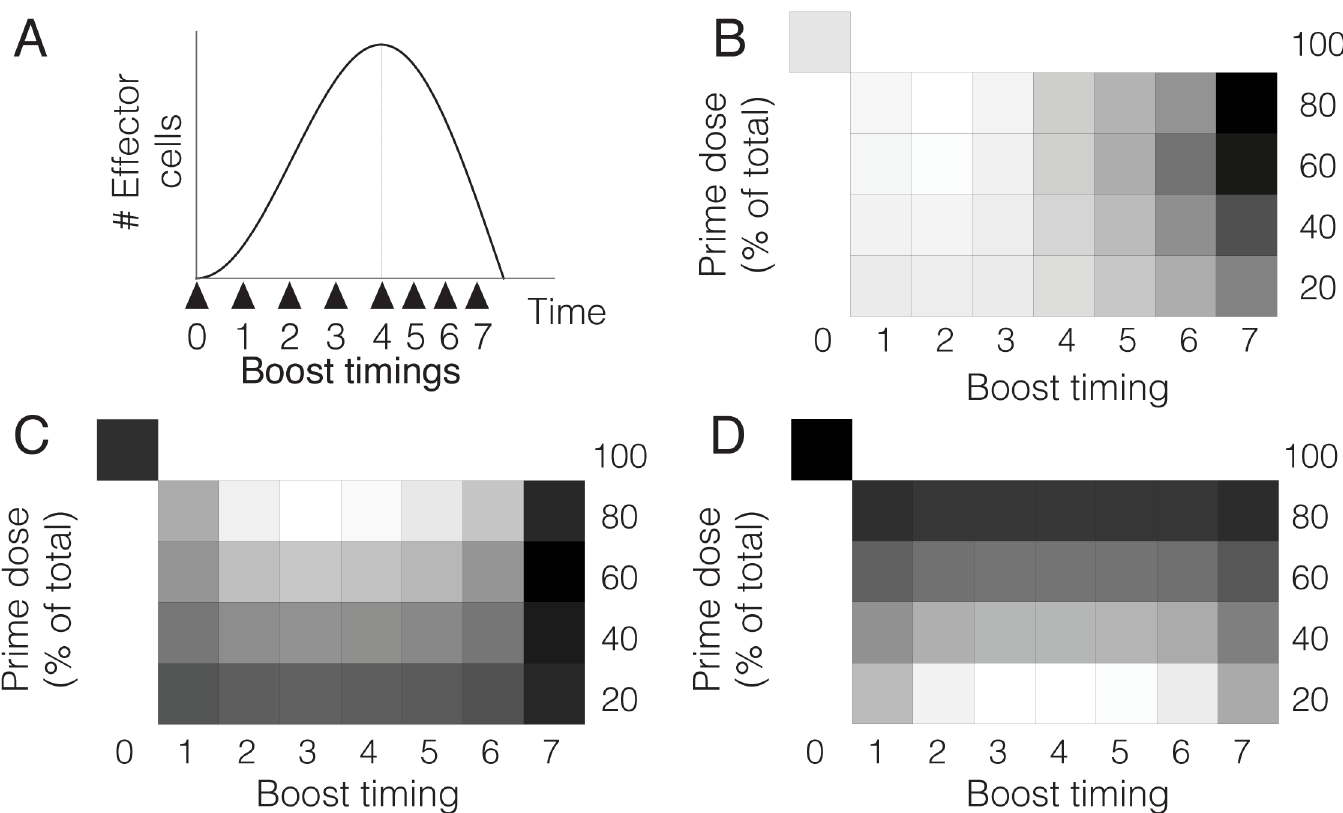
Fig 4. Numerical simulations of the model of T cell dynamics in PB vaccines. Vaccination protocols are defined by initially setting a total antigen dose. A percentage of this total dose (20, 40, 60 or 80%) is used for priming. A) Dynamics of effector T cells (as described by Eq (1)) triggered by priming. The remaining antigen is inoculated at different boost timings chosen relative to clonal expansion and contraction (black arrows). The point marked as zero corresponds to administering all the antigen dose in a single inoculation. B,C,D) Relative performance of PB protocols for low, intermediate and high antigen doses ( A 0 = 2 × 10 2 , A 0 = 2 × 10 3 and A 0 = 2 × 10 4 ) respectively (see Fig A in S1 File). Darker colors indicate greater memory production. These results correspond to 5000 numerical simulations of the model for the indicated antigen doses, with the rest of the model parameters (in suitable units) randomly chosen within the following intervals: 50 (cid:20) λ (cid:20) 10 7 , 1 (cid:20) μ (cid:20) 10, 5 (cid:20) α (cid:20) 15, 0.001 (cid:20) β (cid:20) 0.5 and 1 (cid:20) E a (0) = M a (0) (cid:20) 10.